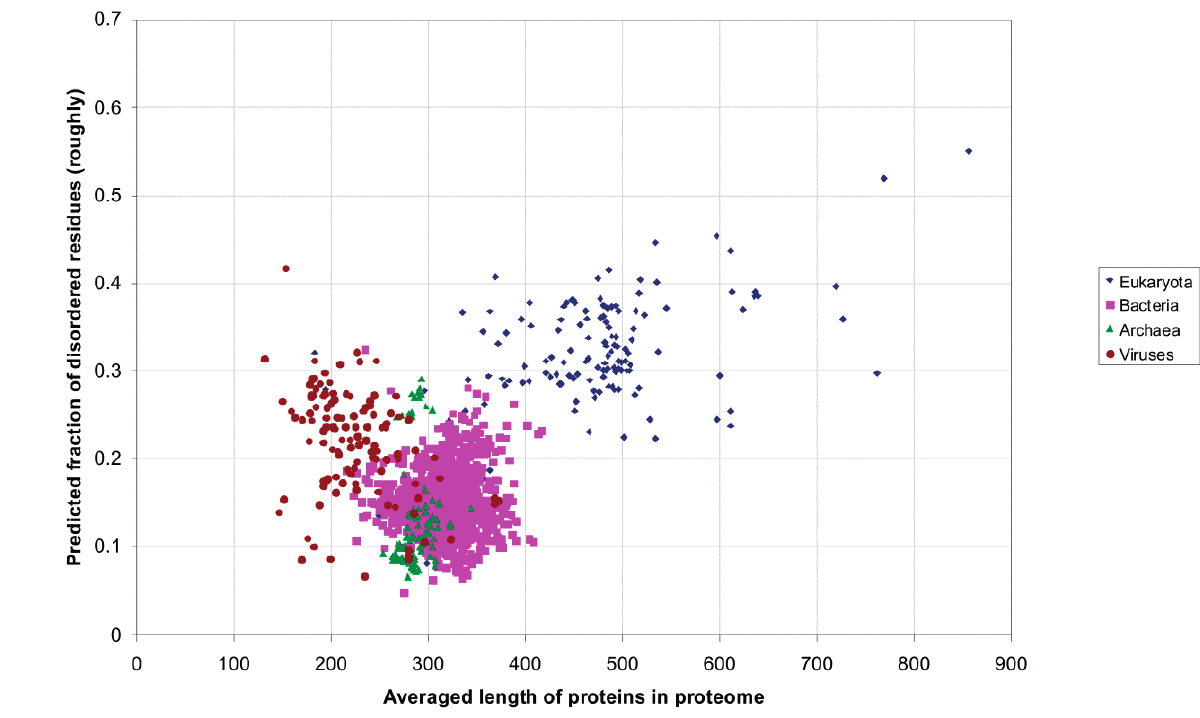
Figure 11. Predicted average fraction of disordered residues for 1902 species from eukaryotes (137), bacteria (1540), archaea (105) and viruses (120) versus the average protein length in the proteome using the rough